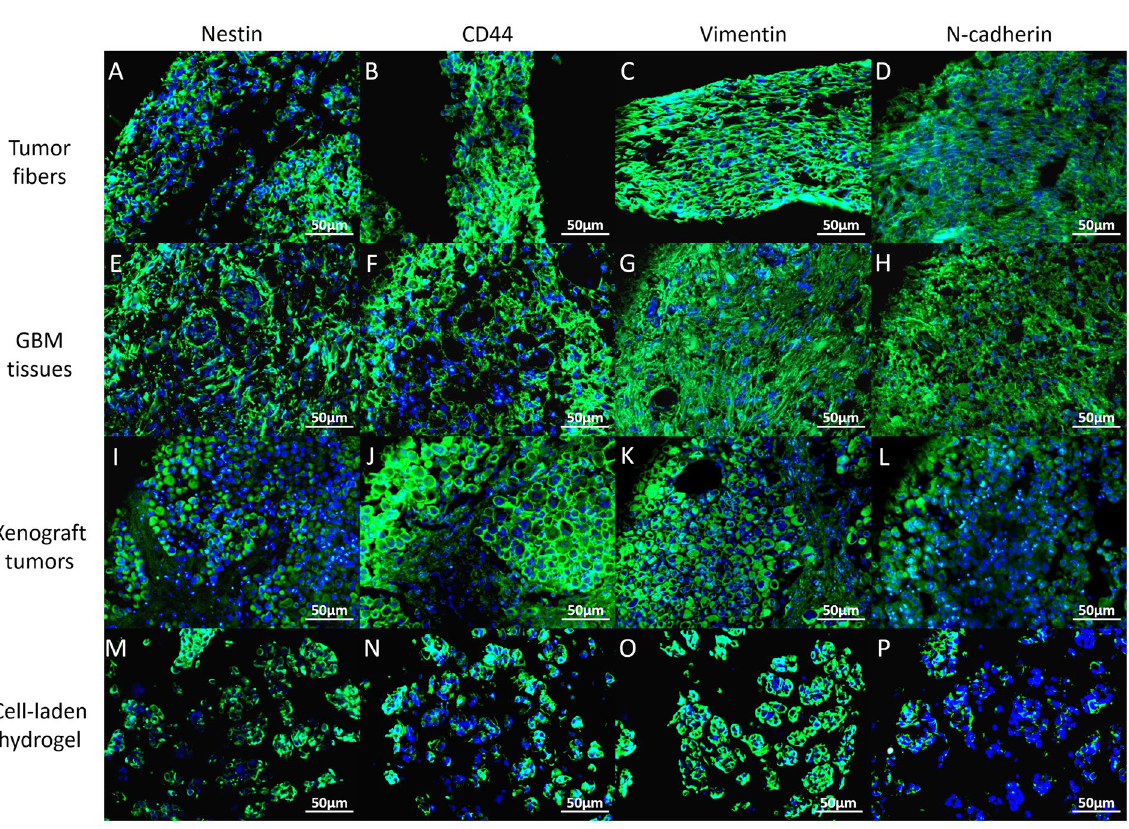
Figure 7. Immunohistology. Expression of biomarkers (Nestin, CD44, Vimentin and N-cadherin) in coaxial bioprinted tumor fibers, comparing to GBM tissues, xenograft tumors and cell-laden hydrogel (cells mixed into A/G). Scale bars: 50 μ